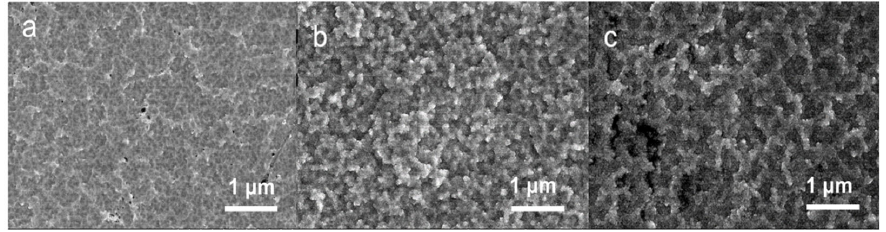
Figure 3. SEM micrographs.of Nb ‐ Zr alloying layers at pressures of ( a ) 30 Pa, ( b ) 40 Pa, and ( c ) 50 Pa.